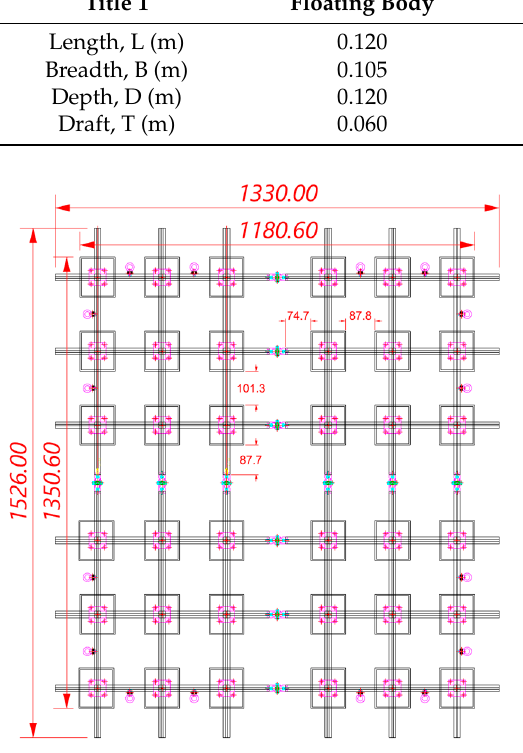
Figure 2. Schematic of the floating solar power farm in the experiment.